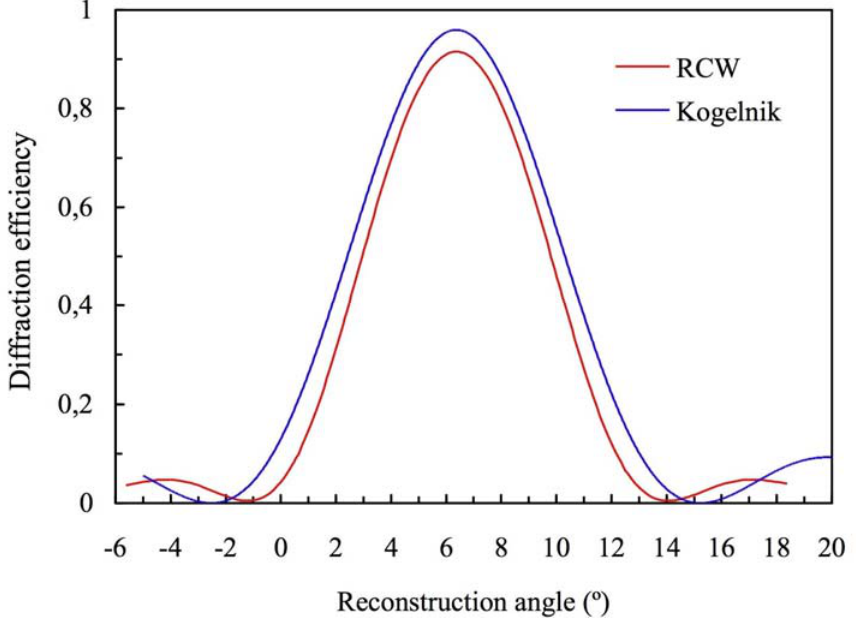
Figure 13. Diffraction efficiency of order +1 for volume transmission gratings with spatial frequency 350 lines/mm, n = 0.011 and 25 µm of thickness at first Bragg’s 1